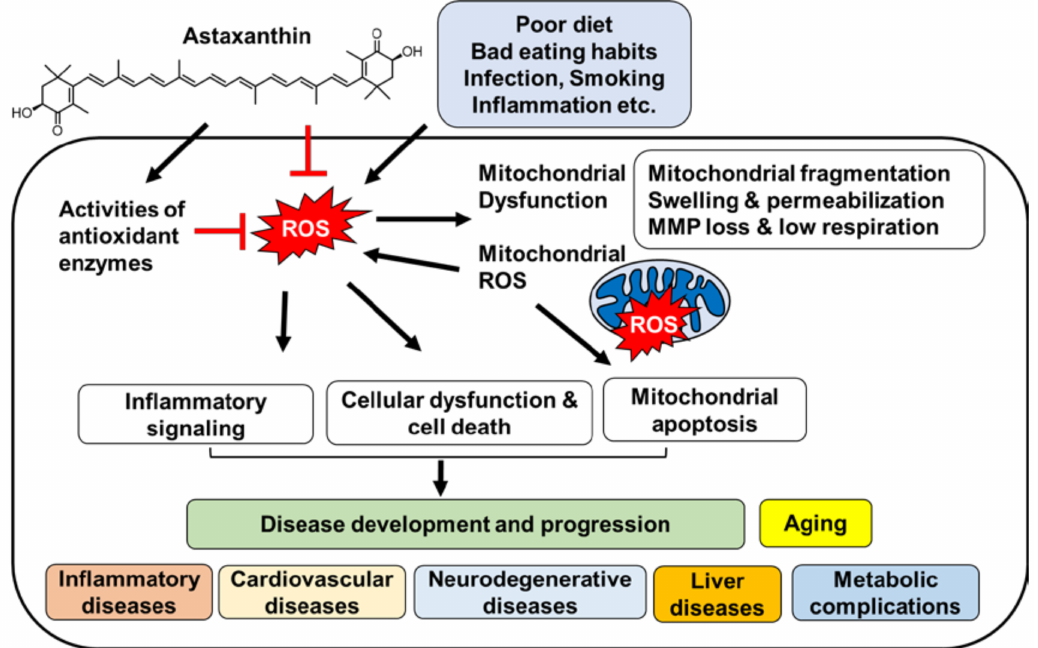
Figure 1. The proposed mechanism by which astaxanthin inhibits oxidative stress-induced mitochondrial dysfunction, and development and progression of